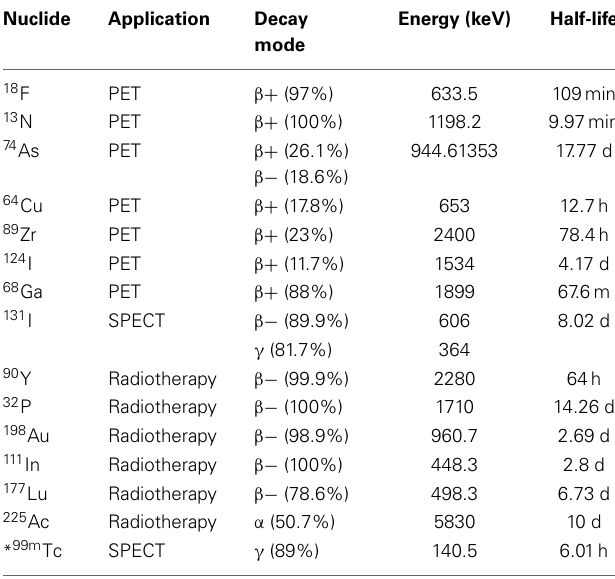
Table 1 | The properties of radionuclides evaluated for CR